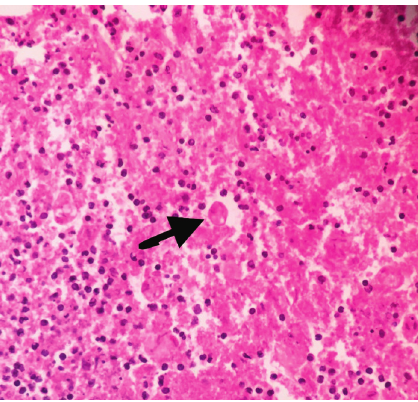
Figure 5: H&E stained tissue from ulcer from the resected specimen of the colon; arrow indicates trophozoites of E. histolytica .